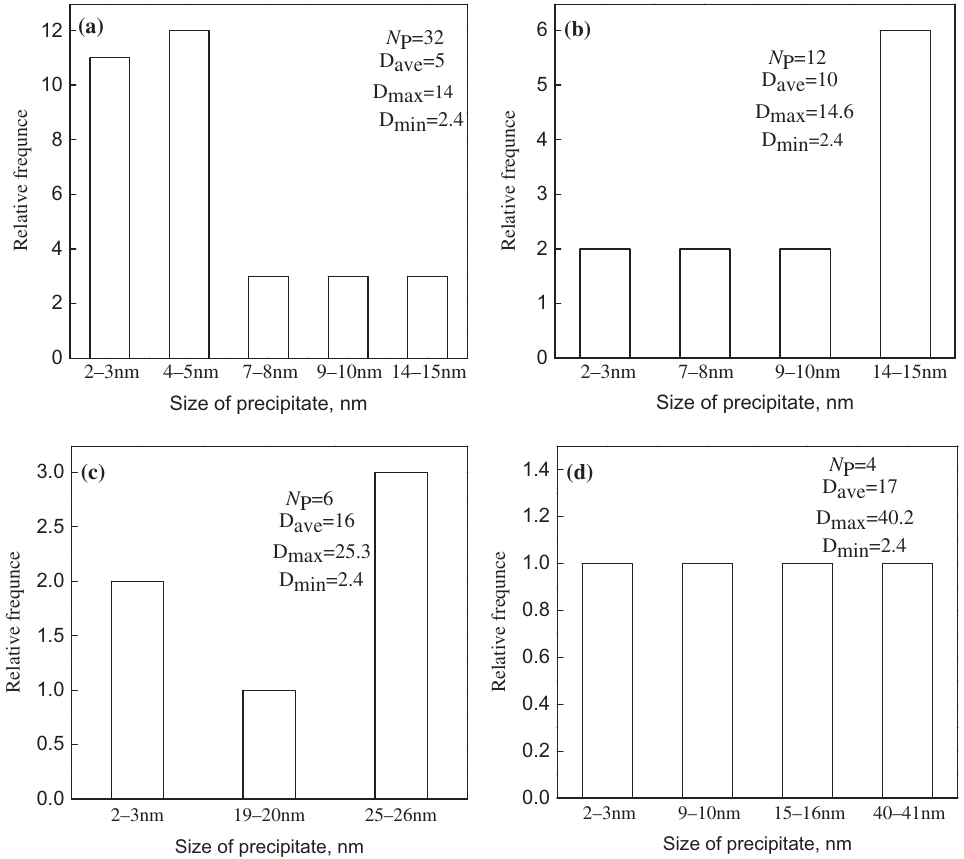
Figure 10: V(C, N) precipitates size distributions of samples deformed under temperatures from 850°C to